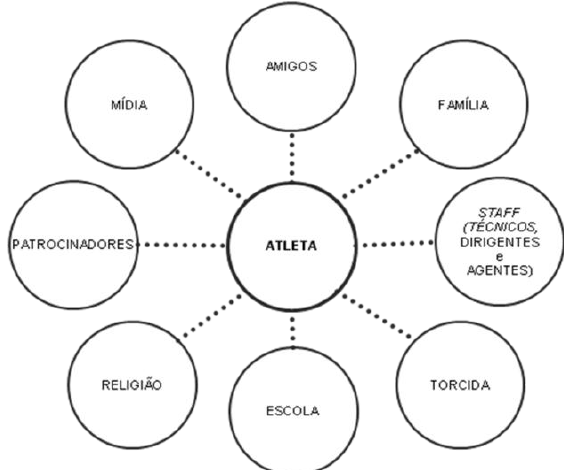
Figura 1. Dinâmicas sociais e o